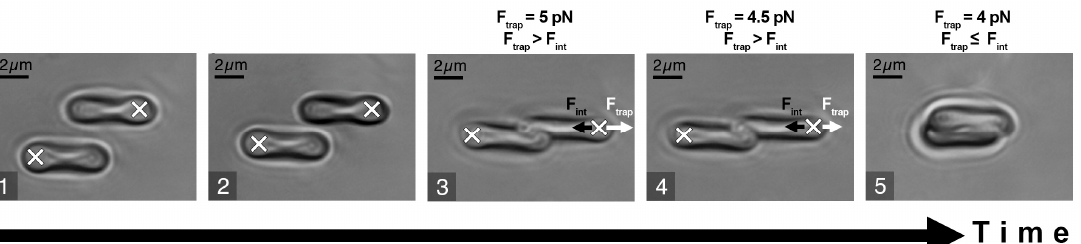
Figure 1. Schematic layout of the two-channeled laser tweezers (LT) used to measure interaction forces F int between two RBCs.